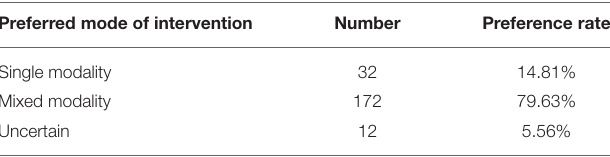
TABLE 4 | Preferred intervention modality of cognitive dysfunction management ( N =